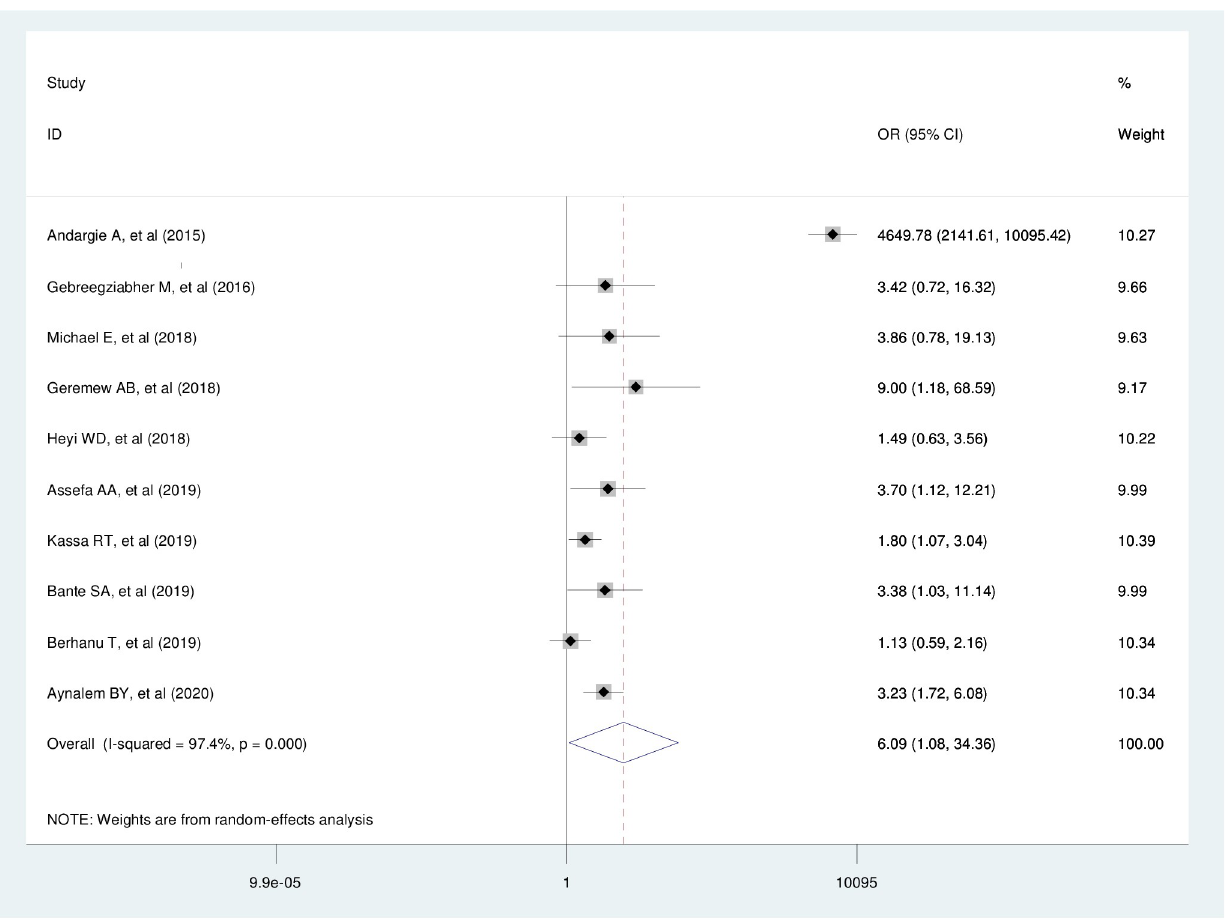
Fig 7. The pooled effect of attitude on cervical cancer screening service utilization.